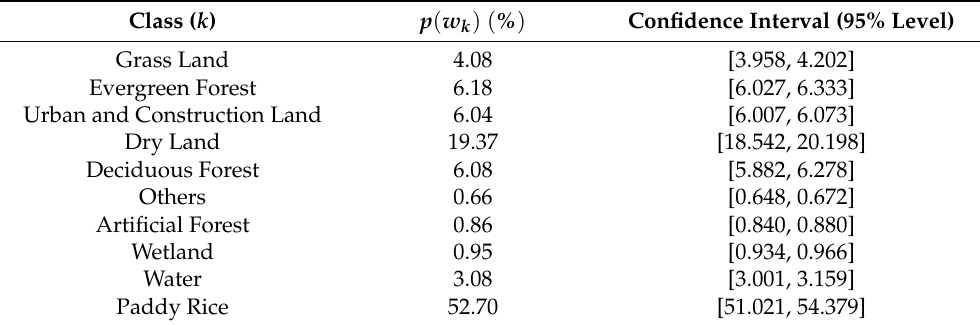
Table A1. Area proportion of each class estimated by group 1 in the Mun River Basin.